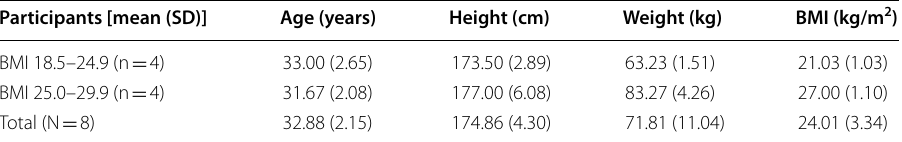
Table 1 Demographic characteristics of the study